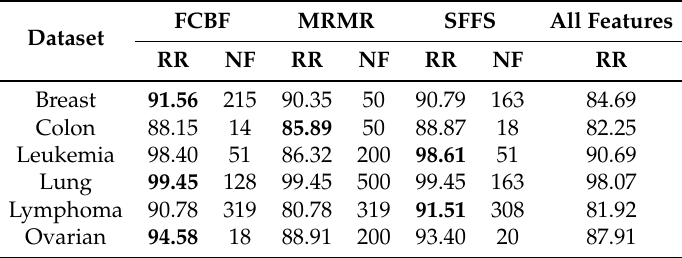
Lung Ovarian Table 5. Best results of heuristic search algorithms for feature selection with RF classifier.